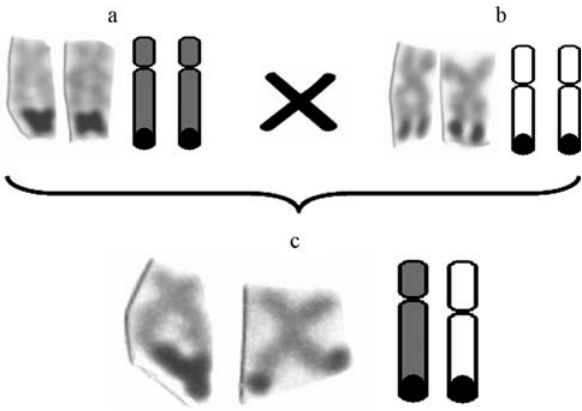
Figure 4 - NOR-bearing chromosomes (silver nitrate staining) in the pa- rental species Leporinus elongatus (a) and L. macrocephalus (b) and NOR-bearing chromosomes in the interspecific hybrid “Piaupara” (c).